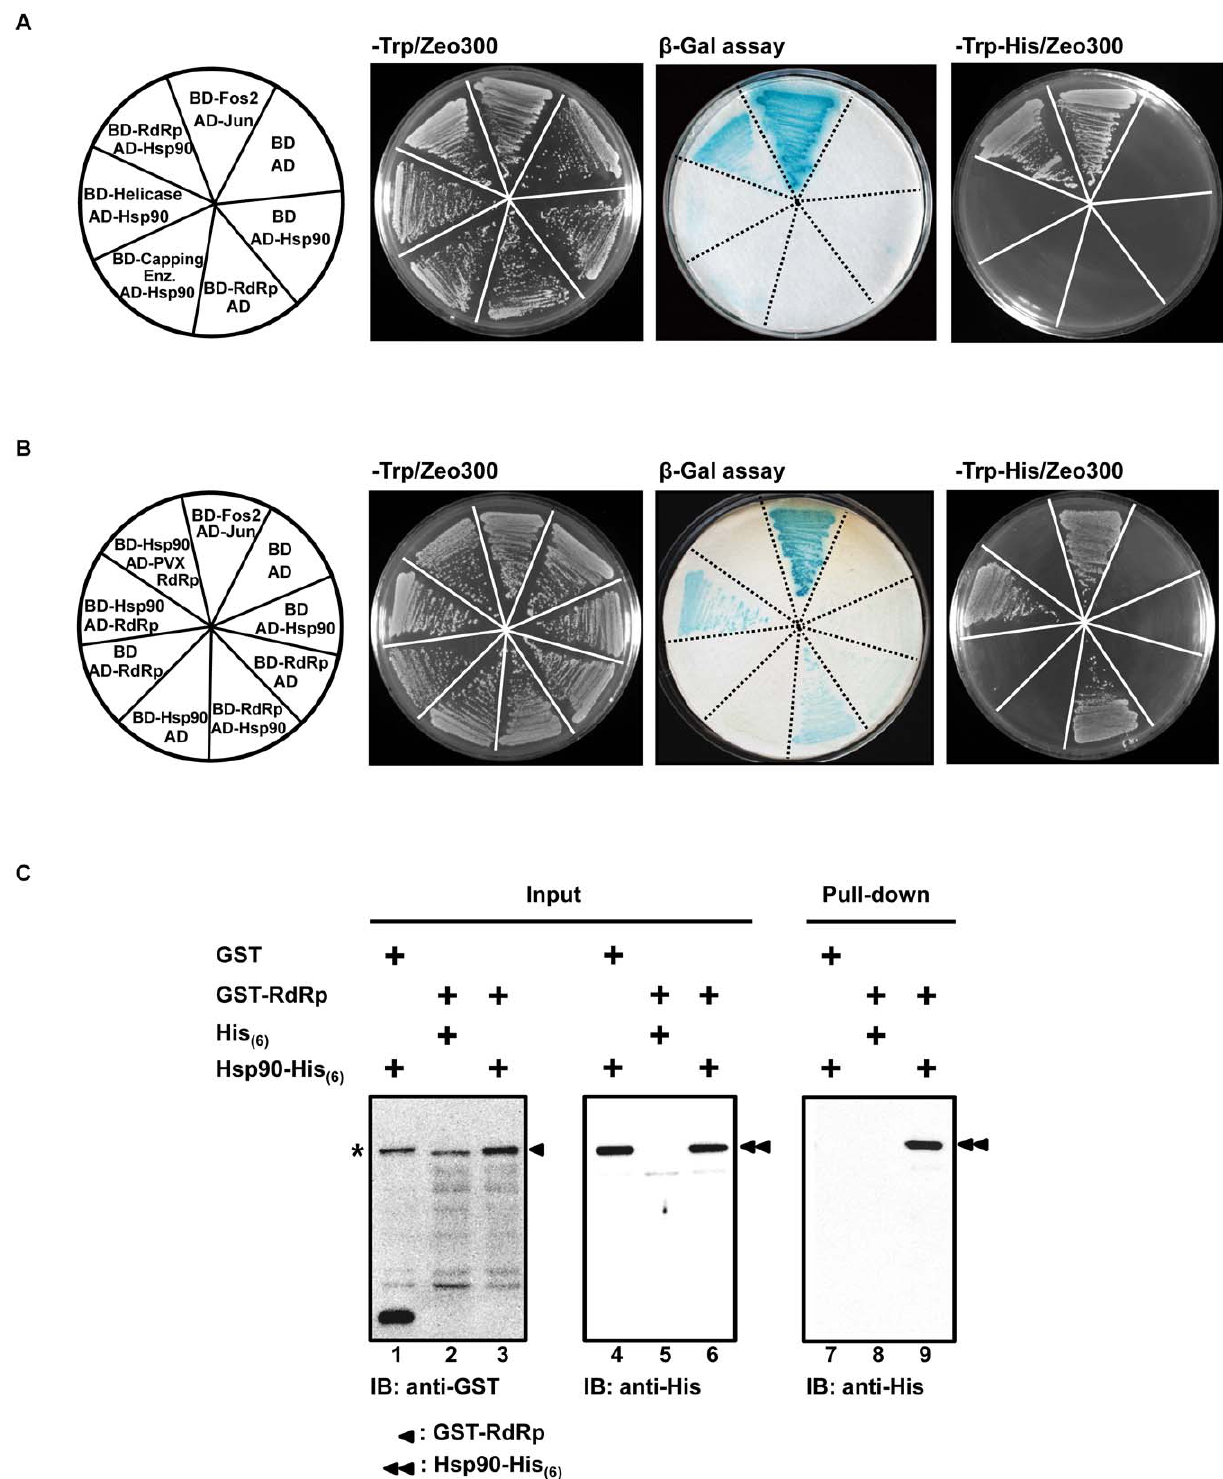
Figure 7. Yeast two-hybrid and GST pull-down analyses for the interaction between NbHsp90 and RdRp domain of BaMV ORF1 protein. ( A ) Mapping of NbHsp90-interacting domain of BaMV ORF1 protein by fusing each domain to Gal4-BD (BD) and NbHsp90 to Gal4-AD (AD), respectively, in the yeast two-hybrid analyses. ( B ) Reciprocal assays with exchanged fusion tags. The BaMV ORF1 protein was divided into three domains; capping enzyme, helicase, and RdRp then individually fused to BD or AD. The plasmids used to transform yeast L40 strain in each section of a media plate are as indicated on the left. Cells expressing BD-Fos2 and AD-Jun were positive controls, while those expressing BD and AD, BD and AD- Hsp90, and BD-RdRp and AD were negative controls. Colonies grown on each section of the -Trp/Zeo300 media plate result from plasmids that successfully transformed into yeast. Colonies grown on the -Trp/Zeo300 plate were transferred to filter paper for b -galactosidase activity assay.